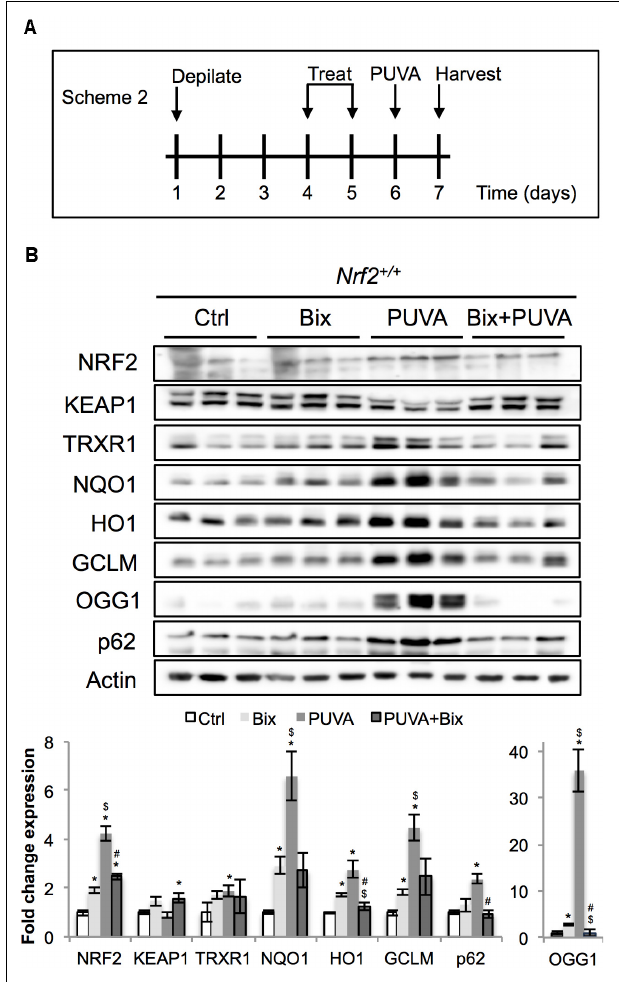
FIGURE 4 | Topical bixin activates NRF2 and prevents acute PUVA-induced damage in C57BL/6J mouse skin. (A) Treatment scheme for acute PUVA study in C57BL/6J Nrf2 + / + mice. (B) Protein expression of NRF2 and its downstream genes in skin tissue lysates as assessed by immunoblot analyses. Protein expression was quantified, normalized, and represented as fold change compared to controls. Blots of three representative samples for each group are shown. p < 0.05: ∗ compared to Ctrl, # compared to PUVA, $ compared to